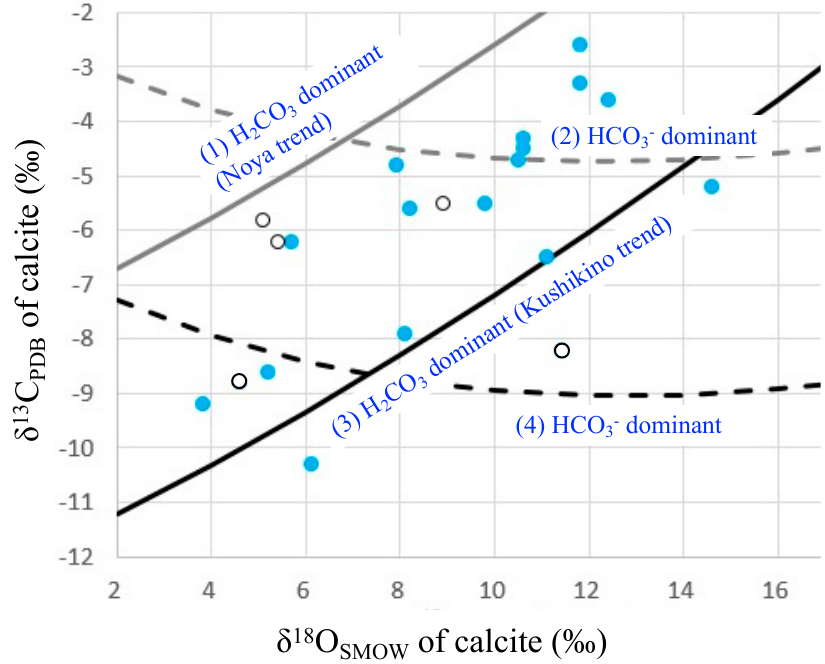
Figure 7. The δ 13 C and δ 18 O values of calcite from the Hishikari deposit are shown. Solid circles are from hand specimens taken in this study (Table 1), and open circles are from an author’s previous work [19]. The equilibrium fractionation trends of calcite for the Noya and Kushikino deposits explained in Figure 6 are also shown.